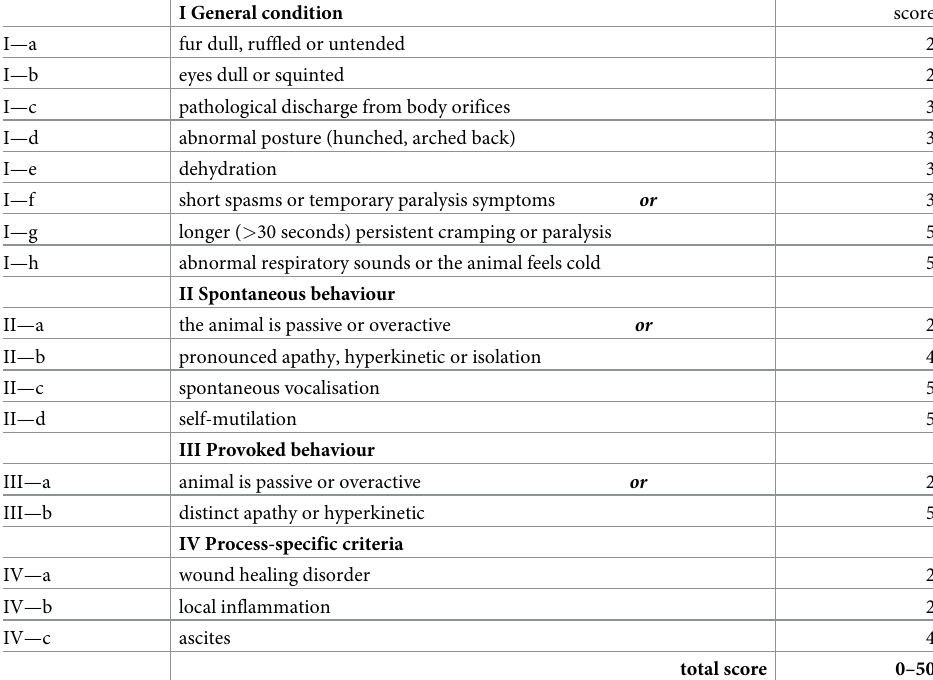
Table 1. Distress score modified according to Kumstel et al.